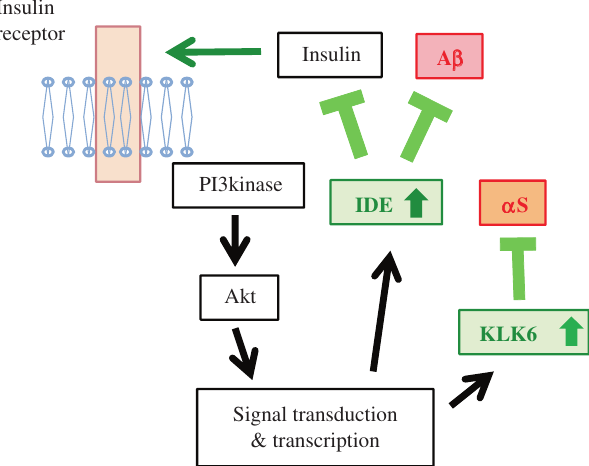
Fig. 4 Insulin receptor signaling activates proteases for amyloido- genic proteins. A schematic fi gure showing that insulin receptor signaling pathway targets IDE and degrades both insulin and A β . Similarly, KLK6 may be regulated by insulin receptor signaling